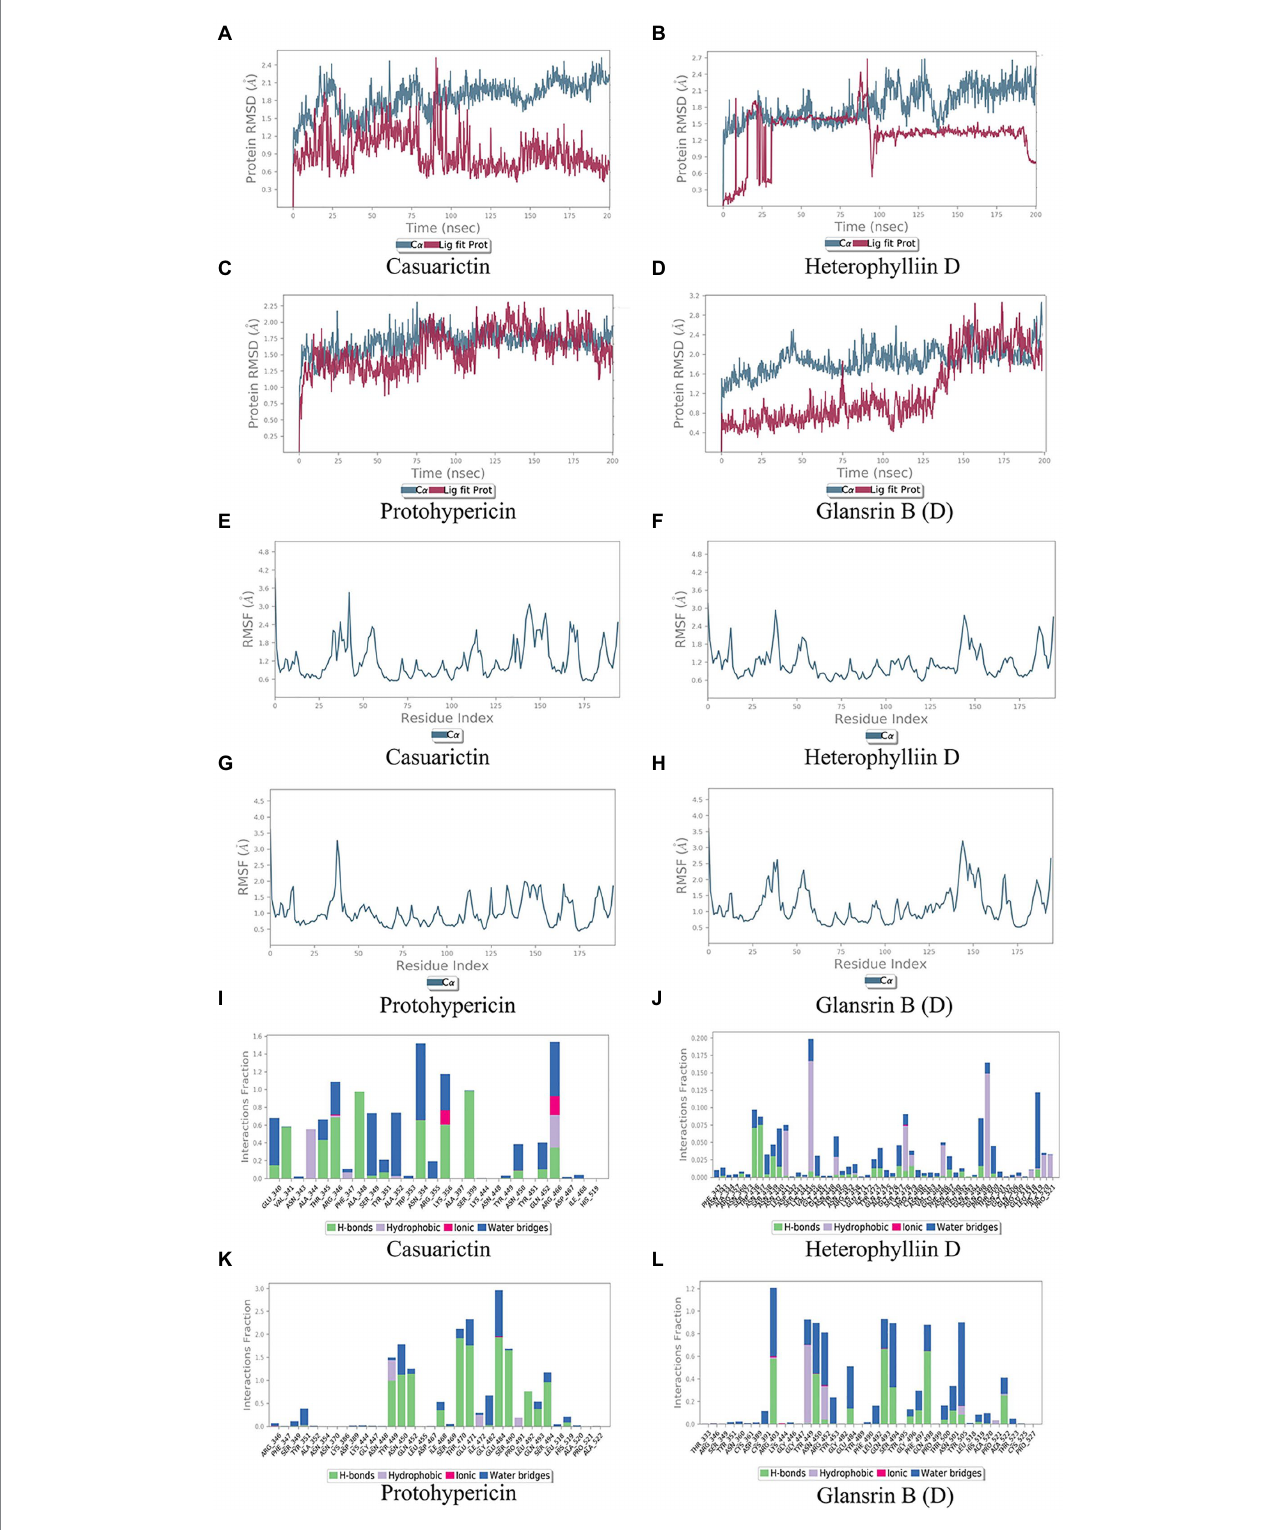
FIGURE 5 Molecular dynamics analysis of the top 2 conformations of small molecular compounds bind to mutation base. The results of protein RMSD, the RMSF of residue index and interactions fraction of Casuarictin (A, E, I) , Heterophylliin D (B, F, J) Protohypericin (C, G, K) and Glansrin B (D, H, L) binds to the S-CTD of Lambda strain and Delta